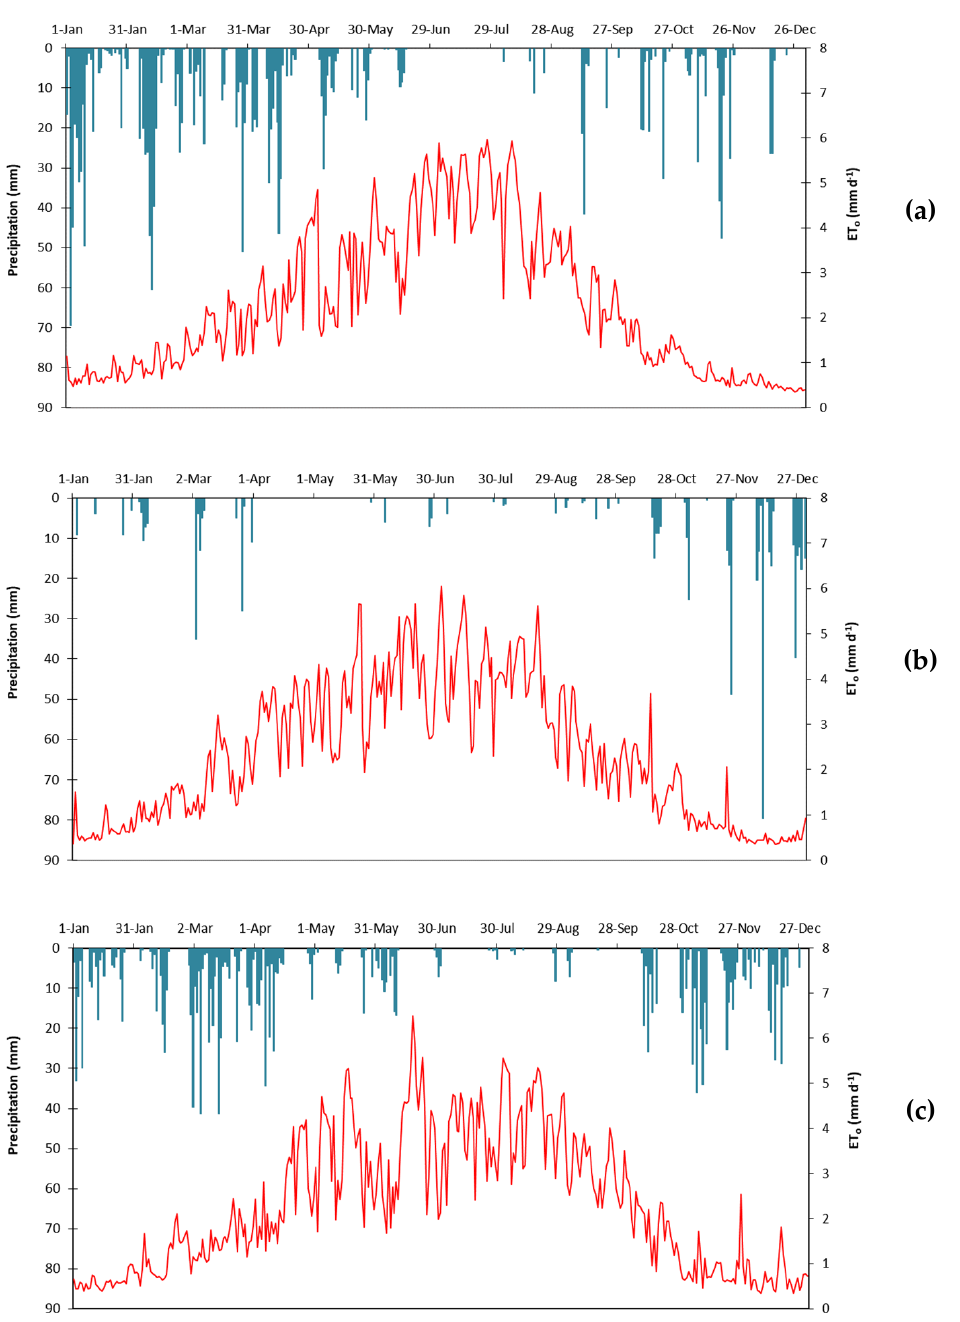
Figure 1. Precipitation (mm, blue bars) and reference evapotranspiration (ET o , mm d − 1 , red line) data: ( a ) 2016; ( b ) 2017; and ( c ) 2018.